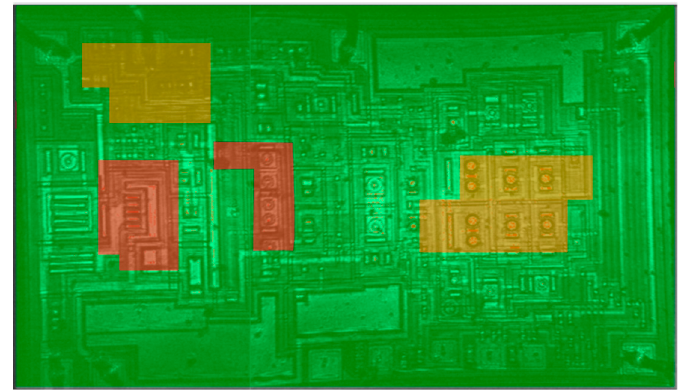
Figure 14. Sensitivity map for OP77 amplifier (laser energy: 4 nJ).